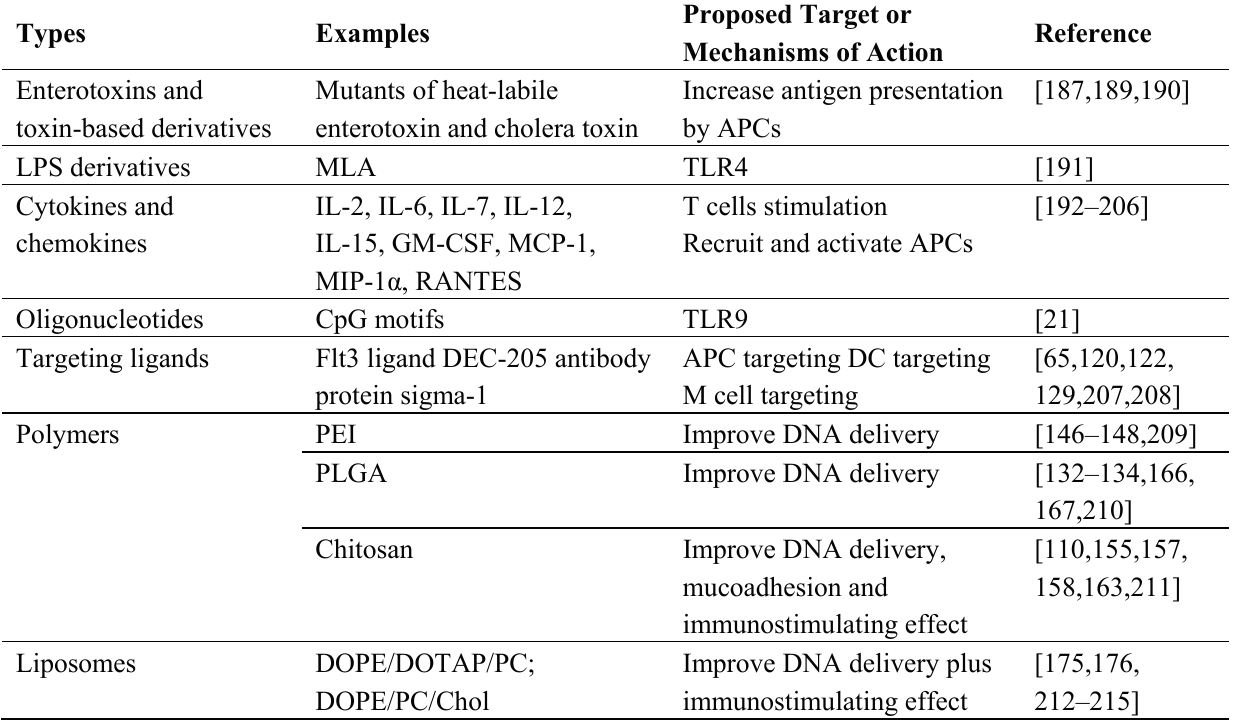
Table 2. Summary of mucosal adjuvants for DNA